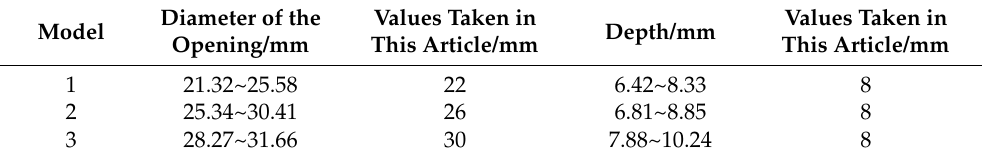
Table 2. Seed extractor